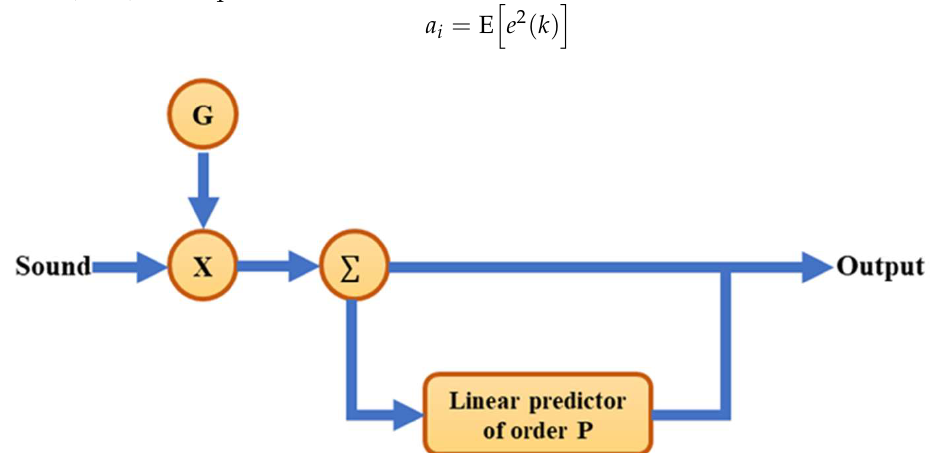
Figure 2. The spectral features filtered by LPC method.